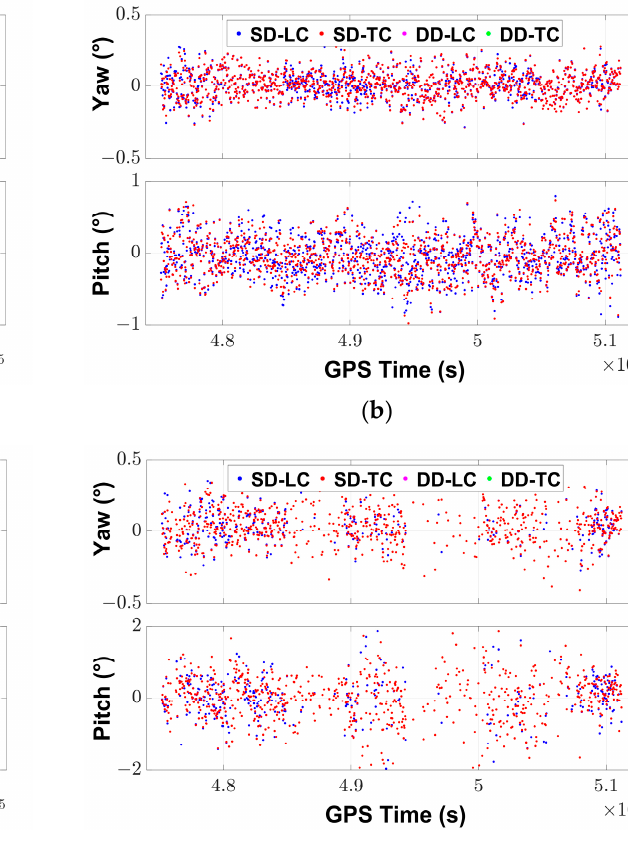
( d ) Figure 4. The positioning error series of the DD-LC, DD-TC, SD-LC, and SD-TC models under dif- ferent elevation cutoff angles in the single-epoch solution: ( a ) 10°; ( b ) 20°; ( c ) 30°; and ( d ) 40°. 4.2.4. Attitude Accuracy Figure 5 shows the attitude (yaw and pitch) error series of the correctly fixed solu-